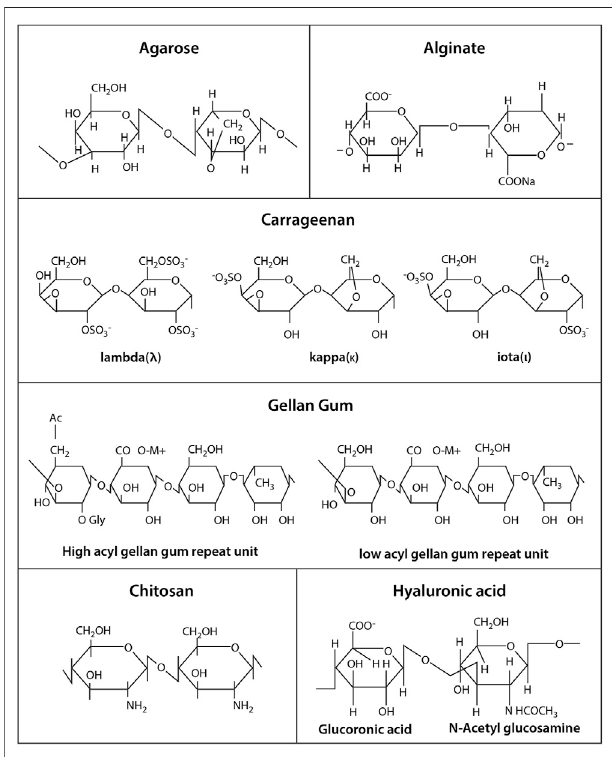
FIGURE 2 | Chemical structures of polysaccharide